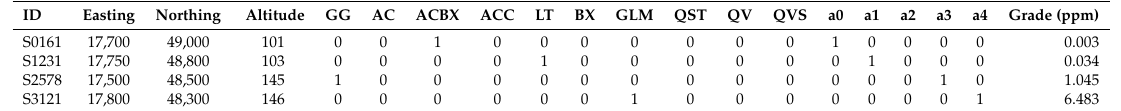
Table 2. Some of sample points from the training